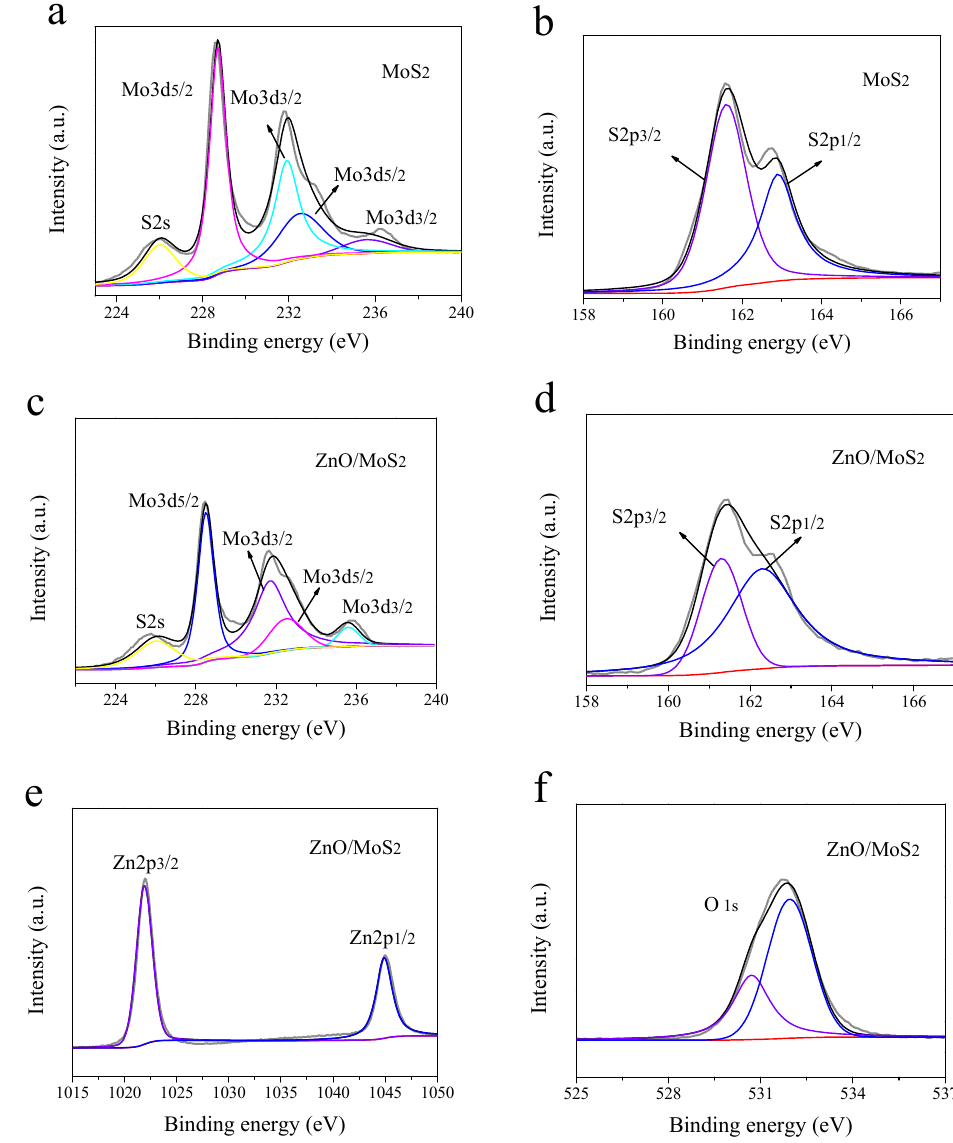
Figure 5. XPS spectra of the MoS 2 nanomaterial: ( a ) Mo 3d and ( b ) S 2p; XPS spectra of the MoS 2 /ZnO nanomaterials: ( c ) Mo 3d, ( d ) S 2p, ( e ) Zn 2p, and ( f ) O 1s.